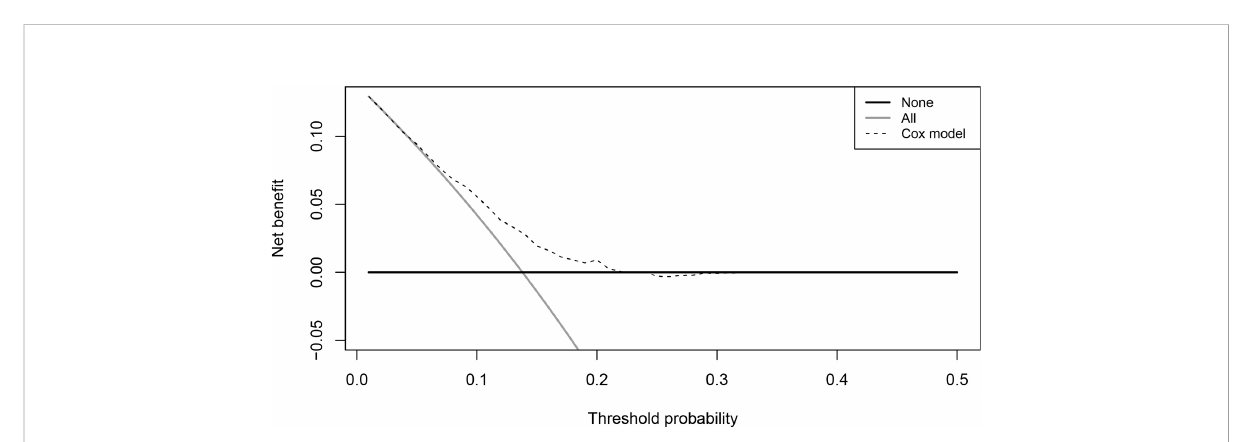
FIGURE 8 Calibration curve of Cox model.